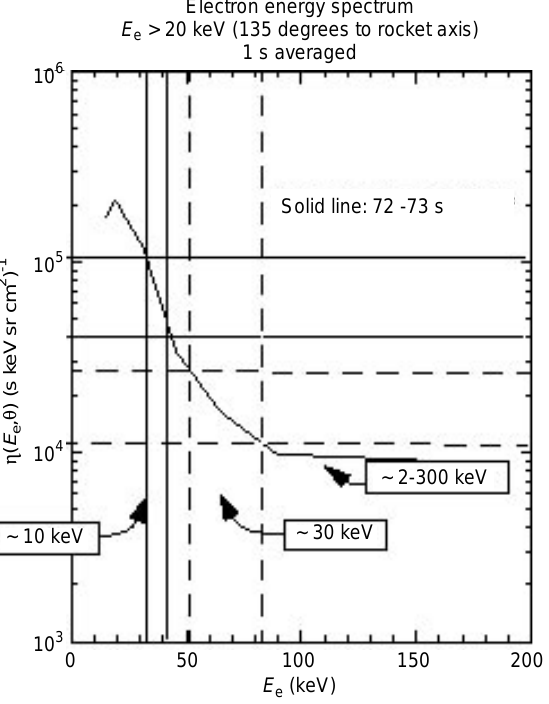
Fig. 12. Electron energy spectrum, backscattered at 72-s flight time; Fig. 11. Calculated electrons from di(cid:128)erential X-ray spectra and directly measured electrons, equivalent isotropic integral fluxes. Upper panel, Solid line : electrons integrated from 10.8 to 250 keV, calculated from X-ray di(cid:128)erential spectra (5.6–100 keV) measured in the azimuth sector from 0 (cid:14) to 30 (cid:14) . Dashed line : directly measured electrons, integrated from 10.8 to 250 keV. Middle panel, solid lines : electron e-folding energy, calculated from the X-ray measurements, both the soft and the hard part of the spectrum. Dashed line : derived electron e-folding energy, assuming that the integral count rates above 25 keV can be represented by only one exponential function. Lower panel, solid line : normalized (to maximum count rate) measured X-rays from 10.0 to 35.4 keV. Dashed line : normalized (to maximum count rate) measured electrons from 10.8 up to 250 keV Table 3. The main results from Figs. 10 and 11 Electrons: measured to calculated (10.8 – 250 keV)